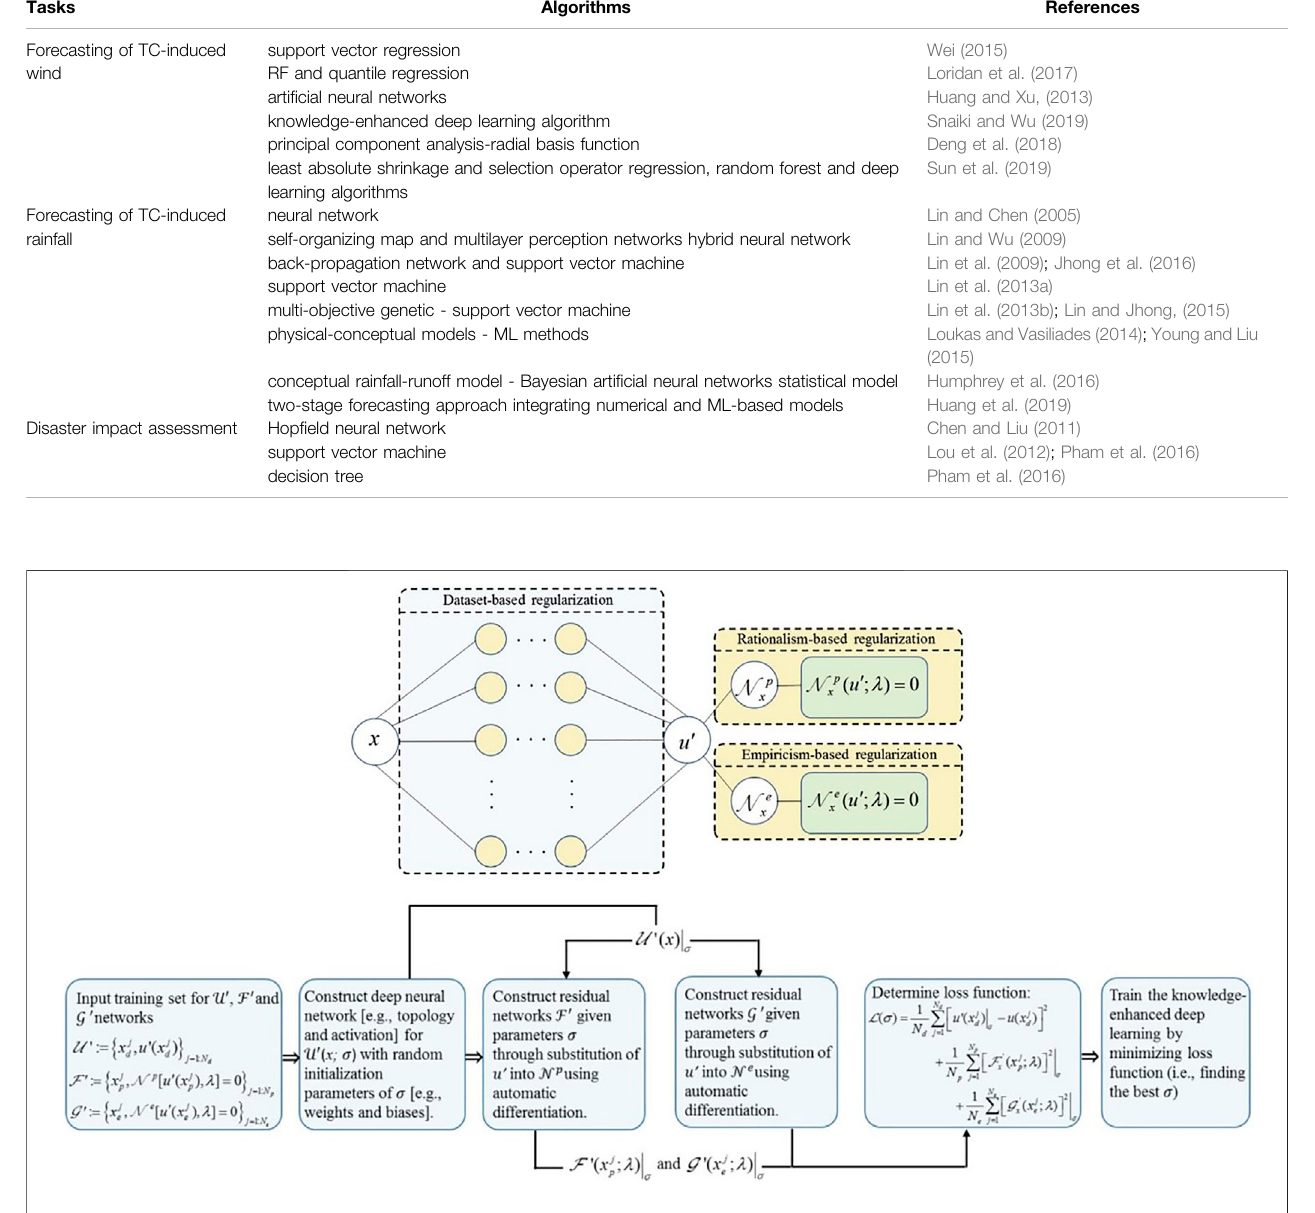
FIGURE 5 | Schematic of knowledge-enhanced deep learning and algorithm (Snaiki and Wu, 2019).